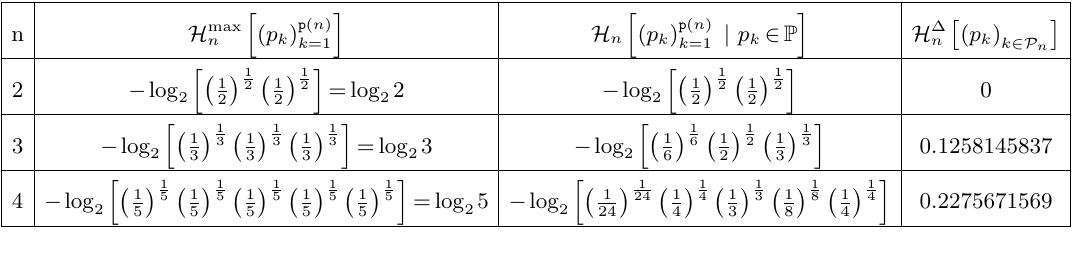
Table 2 . Values of H max